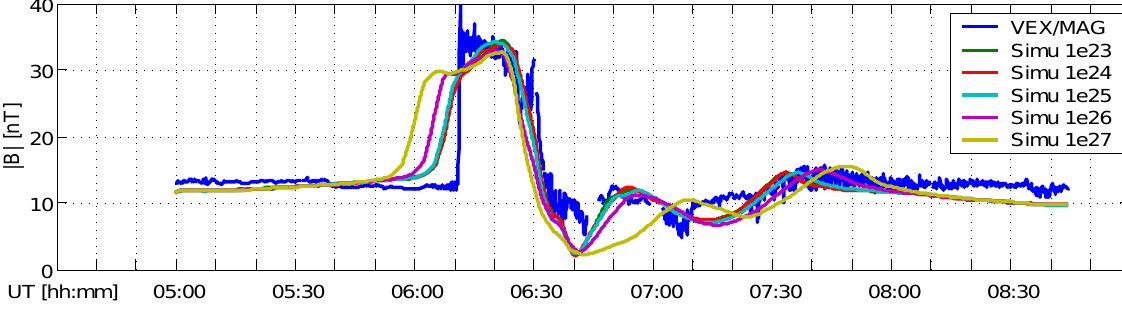
Fig. 6. A comparison of the magnitude of the magnetic field observed by VEX/MAG and five HYB-Venus simulation runs with different O + emission rates. The emission rates are: 10 23 , 10 24 , 10 25 (nominal), 10 26 and 10 27 s − 1 th